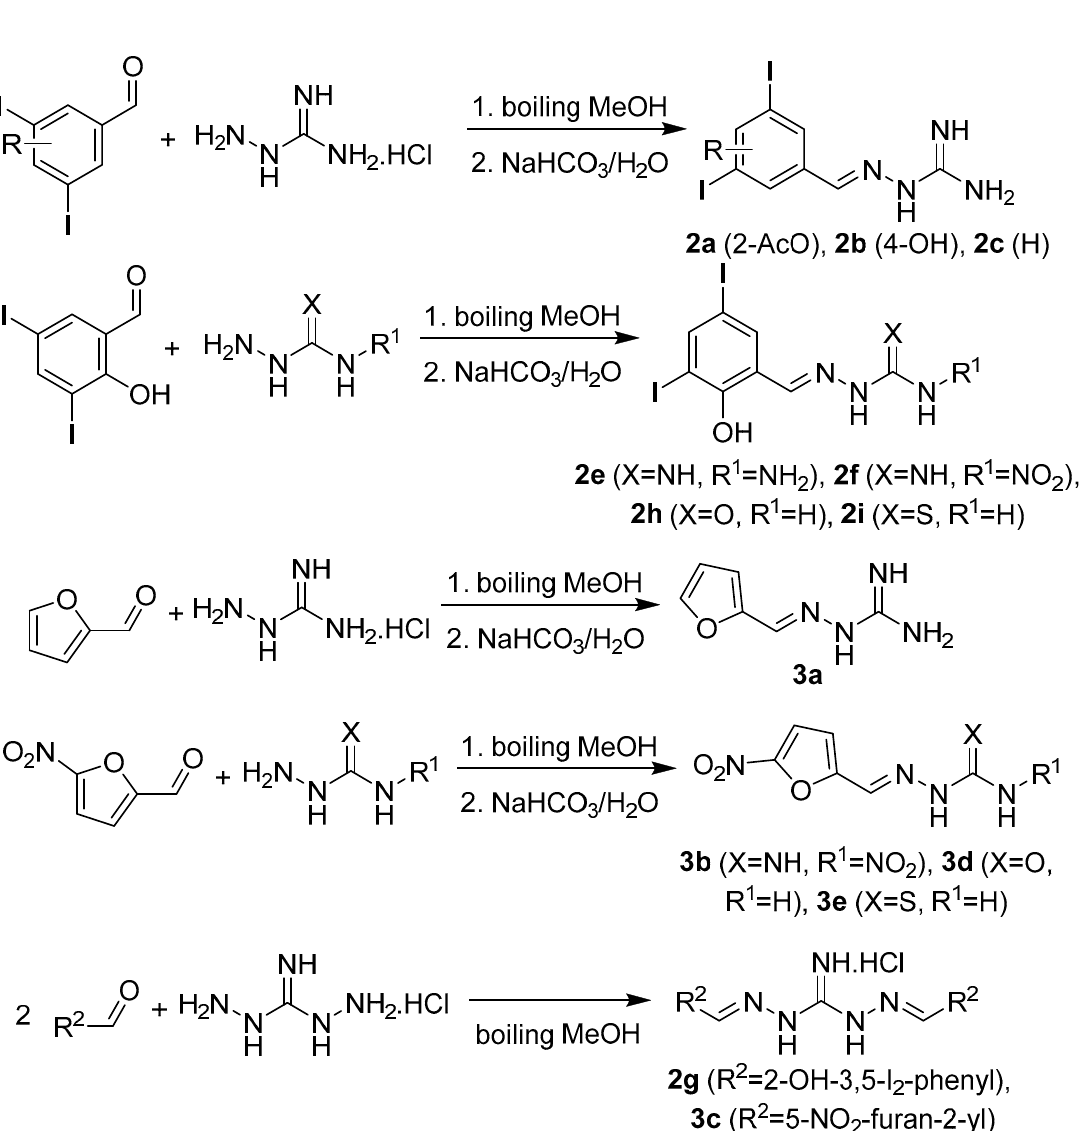
Figure 4. Synthesis of initial series of benzaldehyde/salicylaldehyde/isatin/5-nitroheteroarene-2-carbaldehyde-based ami- noguanidines 1 (R = H ( 1a ), 2-/3-/4-Cl ( 1b , 1c , and 1d , respectively), 2-OH-3-Cl ( 1e ), 2-OH-4-Cl ( 1f ), 2-OH-5-Cl ( 1g ), 2-OH-